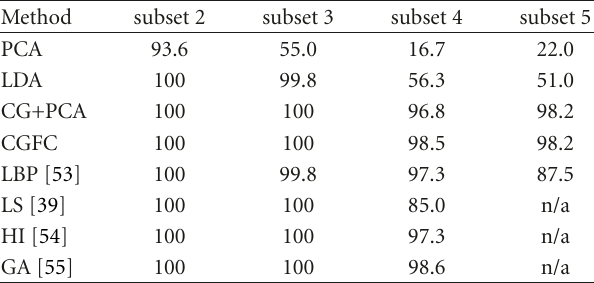
Table 6: Rank one recognition rates (in %) obtained on the EYB database during the comparative